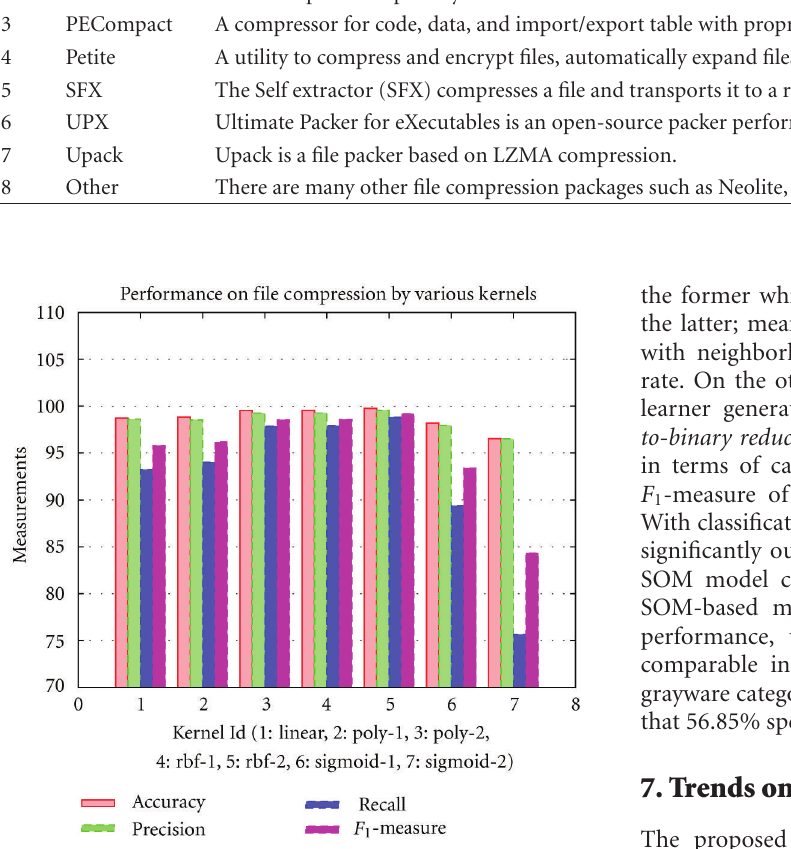
Figure 19: Performance on feature Compression Type by di ff erent